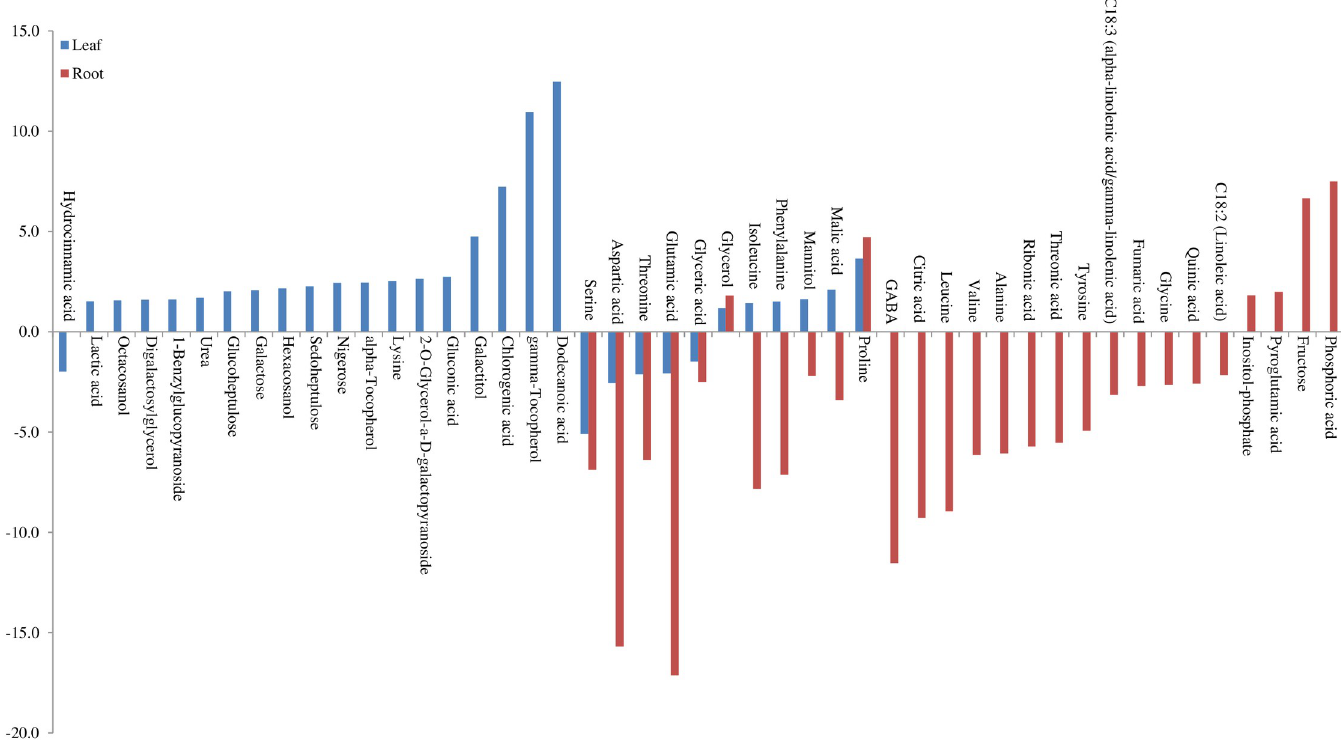
Fig 7. Metabolites of the absolute value of fold change (Drought/Control) which were more than 1.5 in leaf and root separately, and common in both in AGS2038.